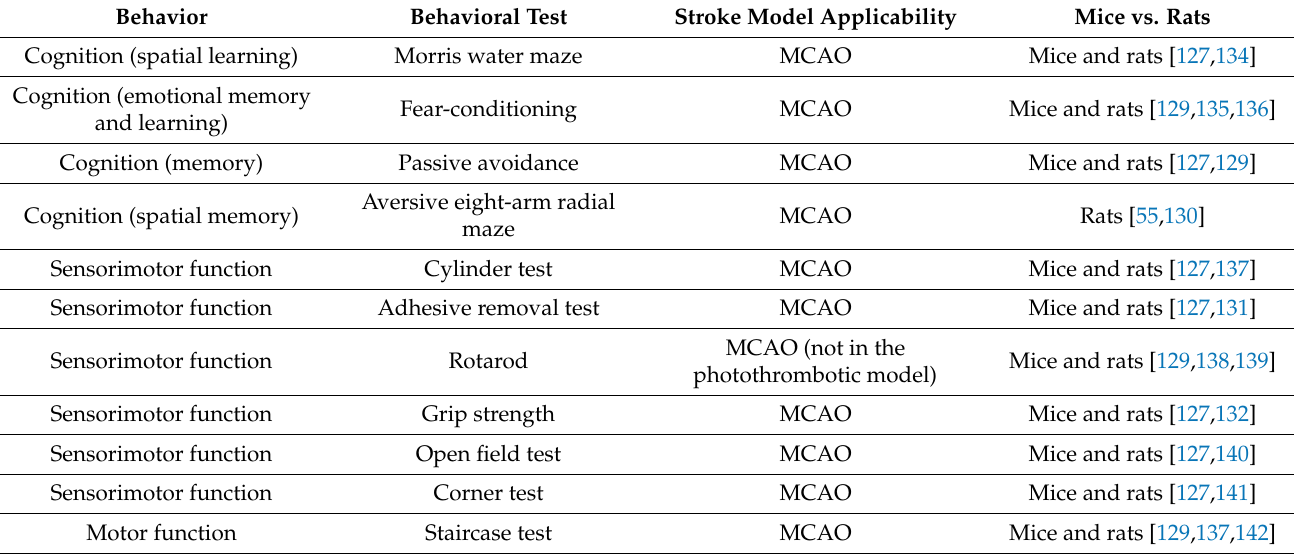
Table 2. Frequently applied behavioral tests in rodents following experimental ischemic